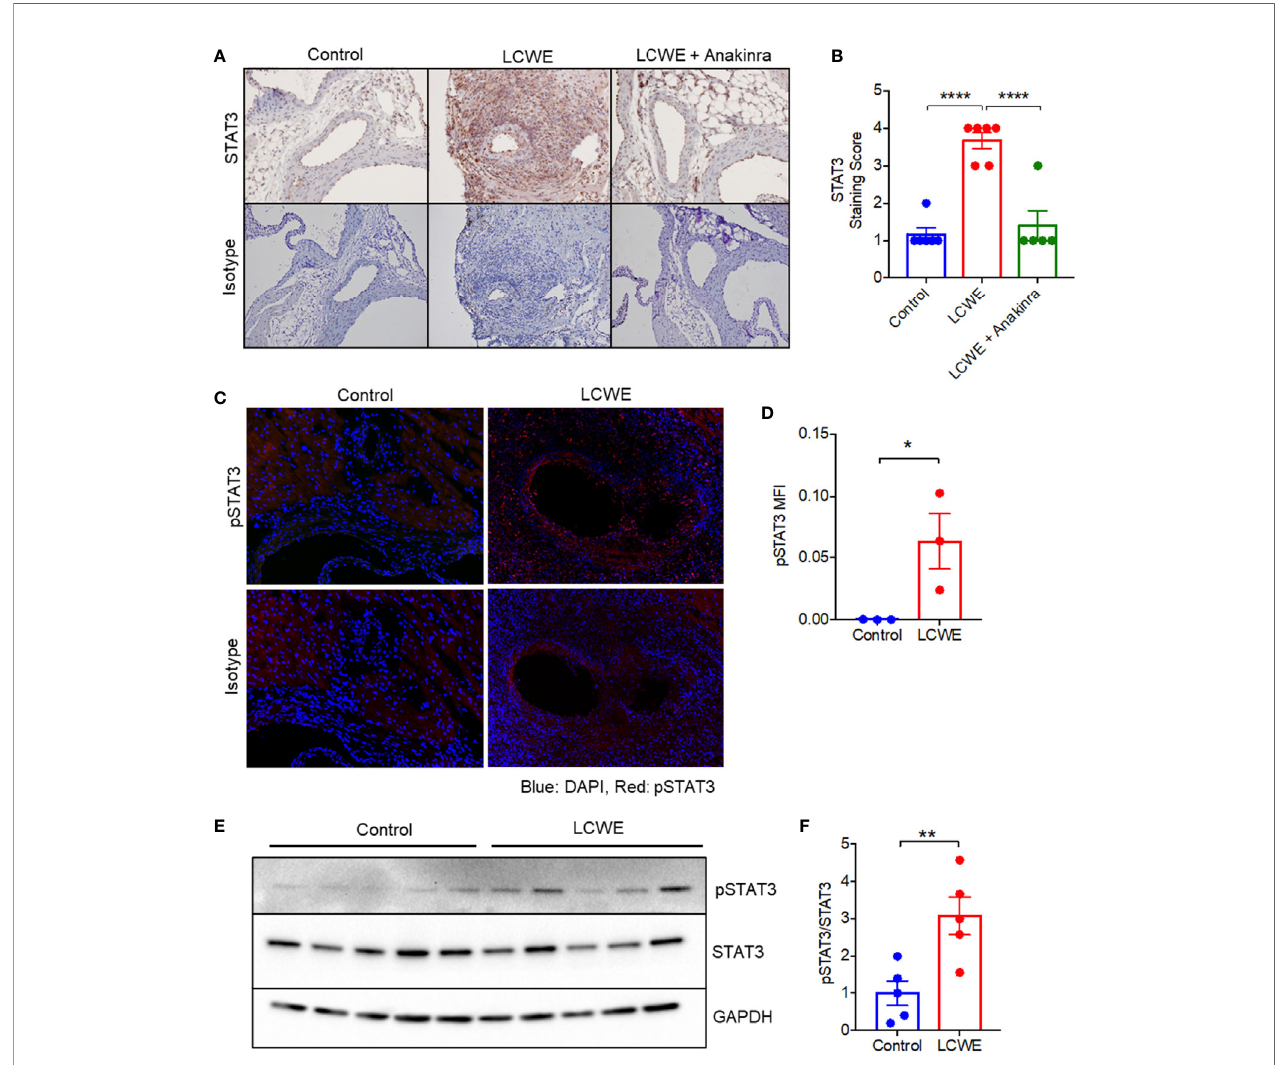
FIGURE 2 | STAT3 expression in the LCWE-induced model of vasculitis and response to anakinra treatment. (A) Representative images of immunohistochemistry staining for STAT3 in murine heart of PBS control, LCWE injected or LCWE injected mice treated with anakinra. (B) STAT3 staining score in PBS control, LCWE injected and LCWE injected mice treated with anakinra. (C) Representative images of pSTAT3 immuno fl uorescence staining in murine heart tissue from PBS control and LCWE injected mice. (D) Quanti fi cation of pSTAT3 immuno fl uorescence staining in murine heart tissue. (E) Western blot of pSTAT3 and STAT3 in murine heart tissue from PBS control and LCWE injected mice. (F) Quanti fi cation of pSTAT3/STAT3 ratio from Western Blot. Data was analyzed by one-way ANOVA with Tukey ’ s multiple testing comparison (B) or Student ’ s t test (D, F) . * p < 0.05, ** p < 0.01, **** p <